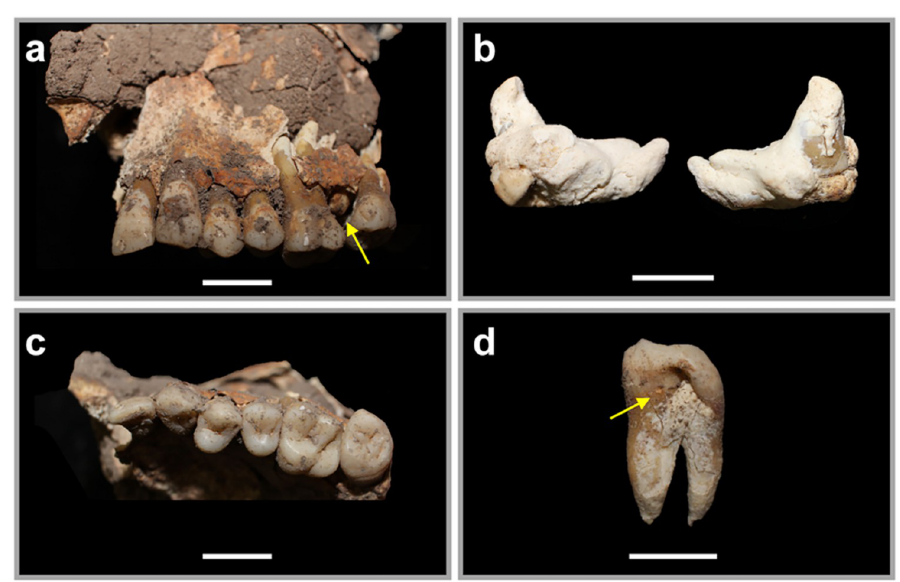
Fig 8. The dental anomalies of Individual 2. a: Labial view of the left maxilla with arrow showing odontogenic cyst in-situ . b: labial and lingual views of the odontogenic cyst. c: occlusal view of the left maxilla. d: the upper left third molar indented from the unerupted growth in mesial view. All scale bars are